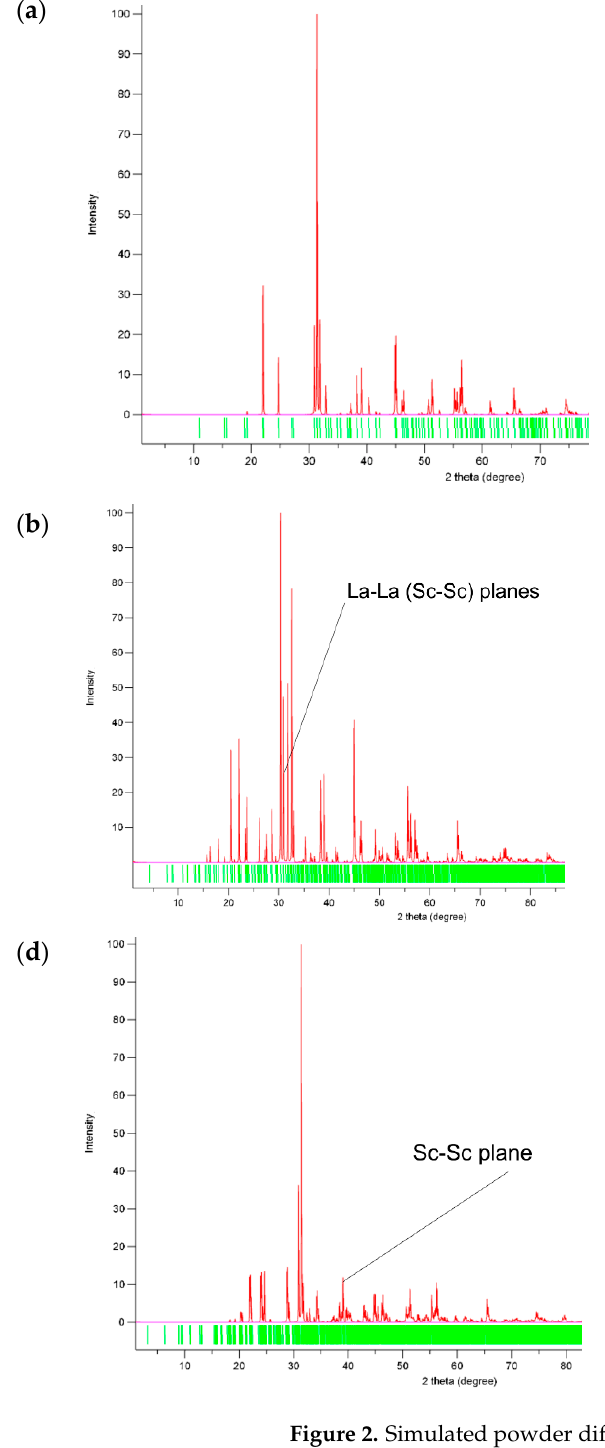
Figure 2. Simulated powder diffraction (XRD) pattern with the source of f E 1.54059 and 1.54432 Å, with intensities of 1 and 0.5, respectively, for ( a ) ideal bulk, ( b ) (100) edge-shared interface, ( c ) (121) edge-shared interface, ( d ) (011) face-shared interface (Figure 1f), and ( e ) (011) face-shared interface (Figure 1g).